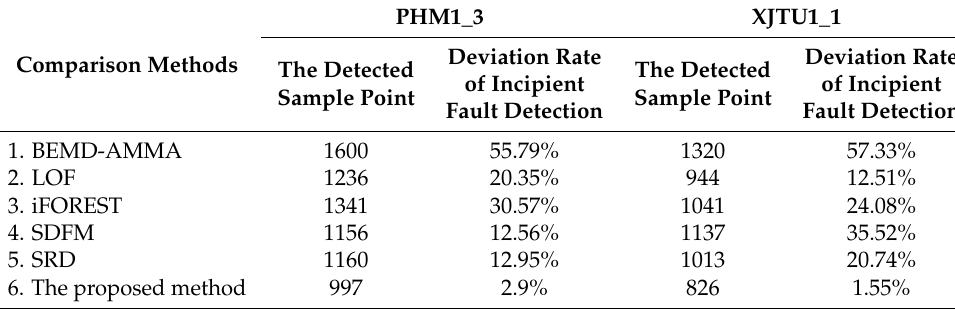
Table 2. Comparison of anomaly detection